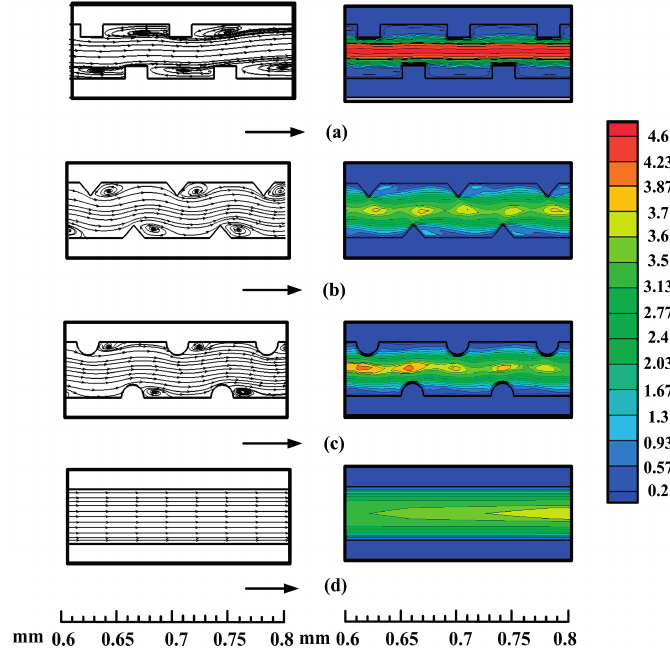
Figure 7. Streamline (left) and flow velocity (right) distribution along the central plane ( z = 0.75 mm) for the ( a ) rectangular ribbed microchannel, ( b ) triangular ribbed microchannel, ( c ) semicircular ribbed microchannel and ( d ) smooth microchannel at Re =